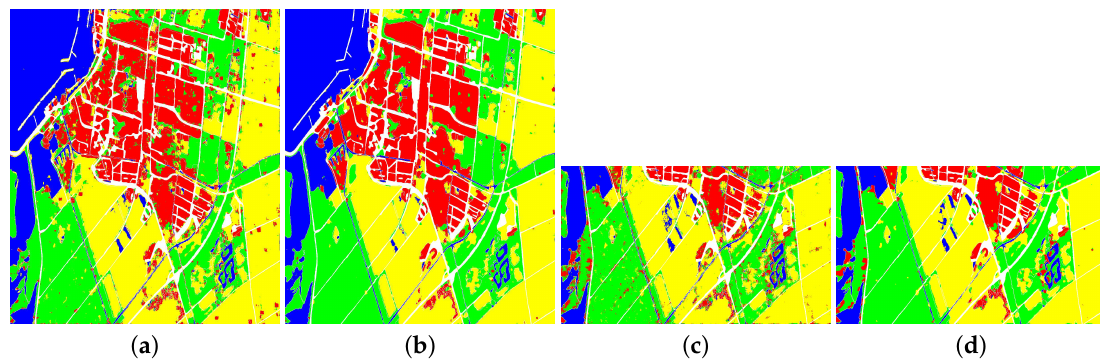
Figure 8. Classification result of RS-2 Flevoland. ( a ) Lenet-5, training with Samples 1; ( b ) FFS-CNN, training with Samples 1; ( c ) Lenet-5, training with Samples 2; ( d )FFS-CNN, training with Samples 2.